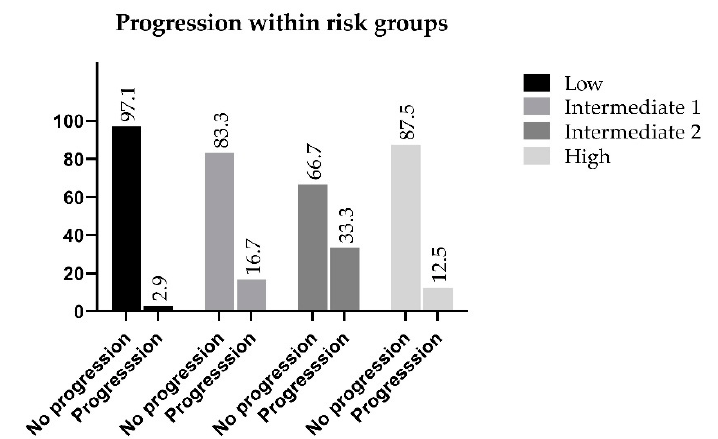
Figure 3. Progression within the reclassified risk groups.